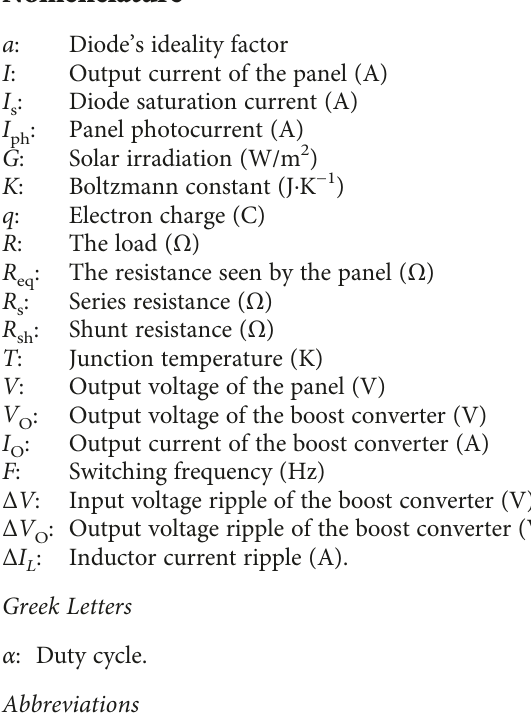
Continuous conduction mode FSCC: Fractional short-circuit current FOCV: Fractional open-circuit voltage